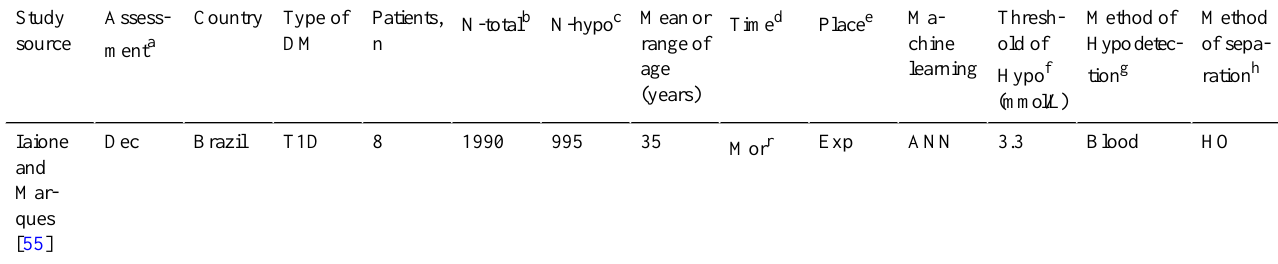
[55] a Ability for which the machine learning algorithm was assessed. b N-total: total number of data included in test data. c N-hypo: total number of hypoglycemic episodes included in the test data. d Time of day when hypoglycemia occurred. e Place of supposed hypoglycemic episode. f Threshold of glucose level that was used to diagnose hypoglycemia. g Method for separating training and test data. h Method used for diagnosing hypoglycemia. i DIA: DIAdvisor. j Child: ChildrenData.